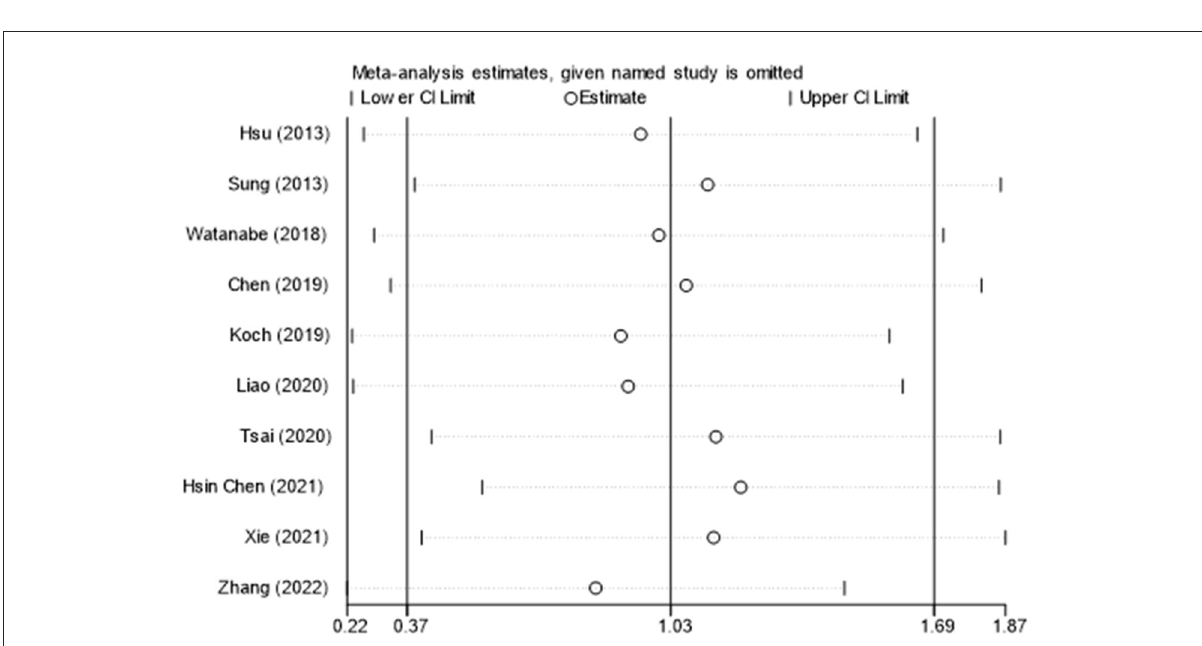
FIGURE3 The sensitive analysis of FMA change from baseline. The white circle indicates the pooled Std.MD for excluding each RCT. The extending lines indicated the pooled 95% CI of Std.MD for excluding each RCT.